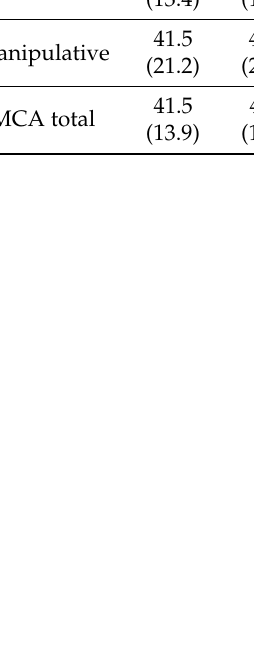
MCA: Motor Competence Assessment; Boys and Girls-ANOVA Repeated Measures with Age Group as a factor (NS for all ANOVAS); Total-ANOVA Repeated Measures with Age Group and Gender as a factor (NS for all ANOVAS).